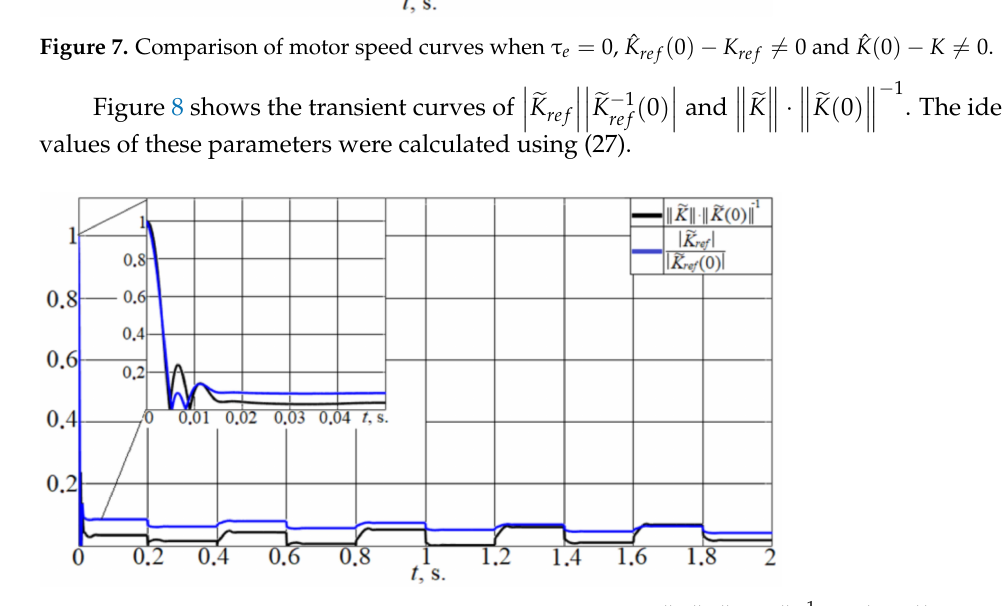
(cid:13) (cid:13) (cid:13) (cid:13) (cid:13)(cid:101) K (cid:13) (cid:13) (cid:13)(cid:101) K ( 0 ) · (cid:13)